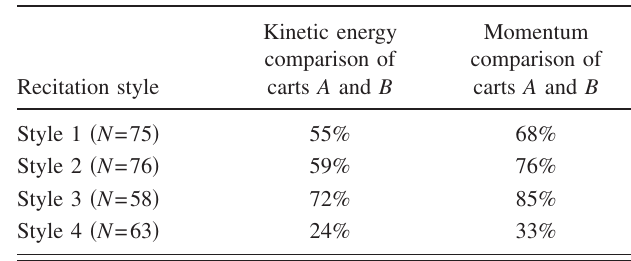
TABLE IV. Student performance on post-test question 2.